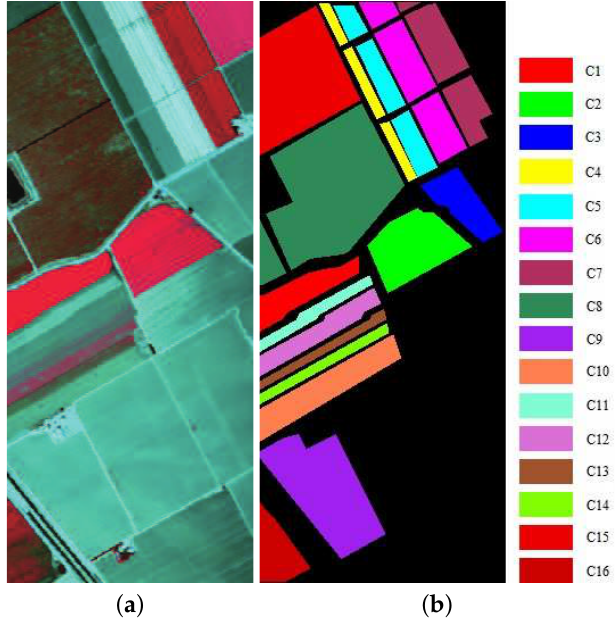
Figure 7. ( a ) False color hyperspectral image (HSI) over Salinas Valley (using bands 68, 30, and 18); ( b ) Ground truth of the labeled area with 16 classes of land cover: Broccoli green weeds 1, Broccoli green weeds 2, Fallow, Fallow rough plow, Fallow smooth, Stubble, Celery, Grapes untrained, Soil